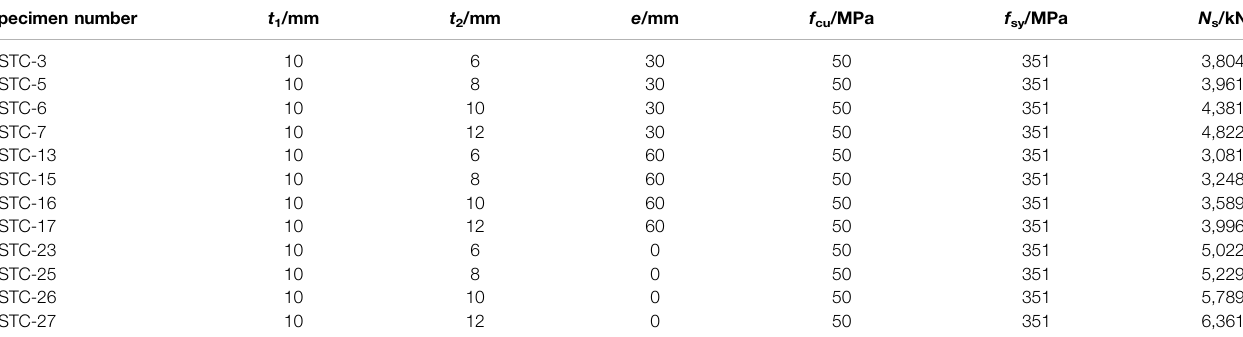
TABLE 7 | Ultimate eccentrical compression bearing capacity of specimens with different thicknesses. Specimen number